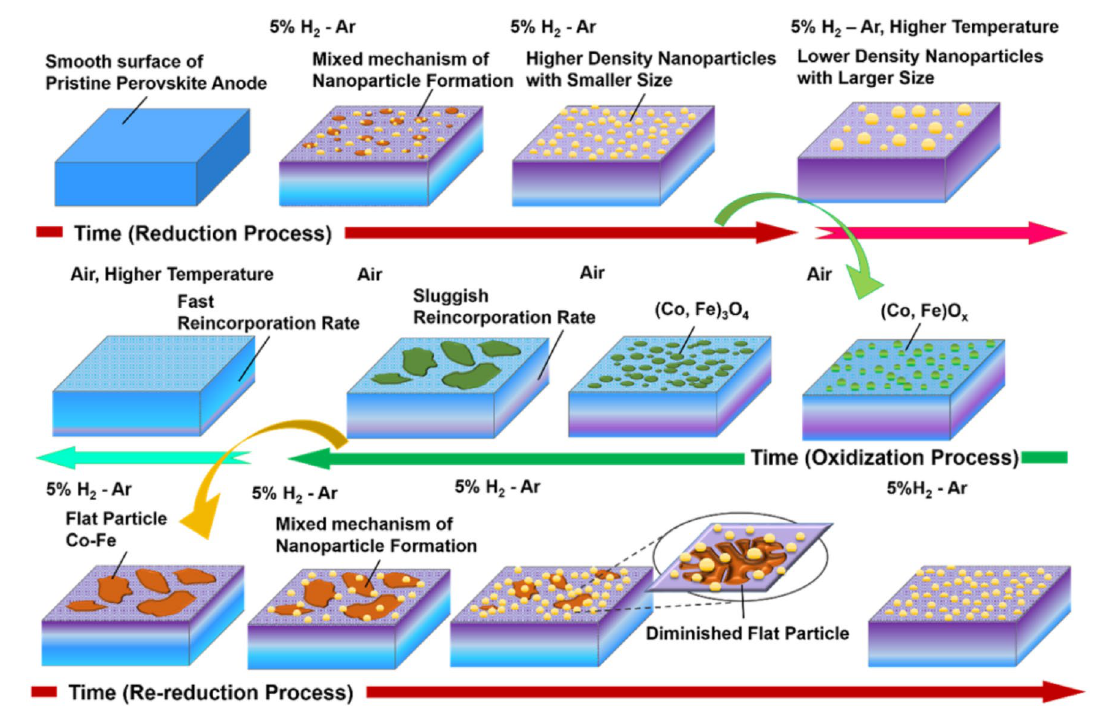
Fig. 7 The self-regeneration mechanism for LSCrFeCo10 with respect to processing time and temperature. Reproduced with permission [56]. Copyright 2018, ACS Publications